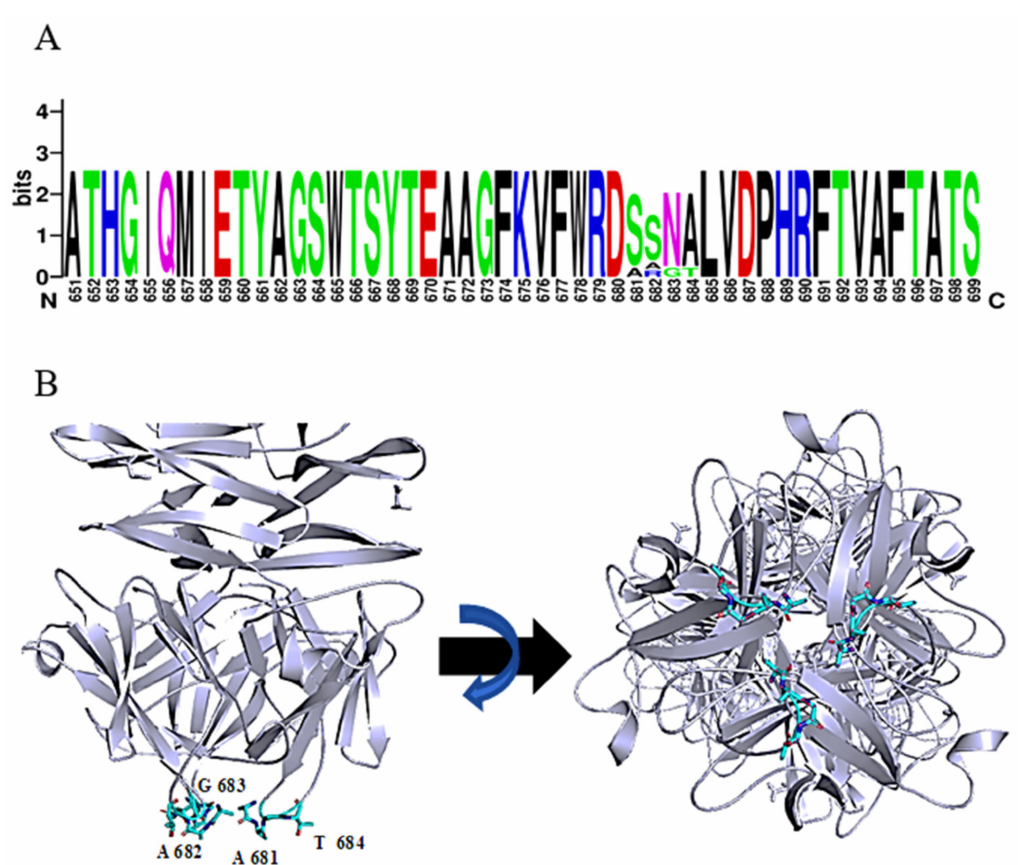
Figure 5. Consensus sequence S/A-S/A/R-N/G-A/T in the most ultimate loops of the C-terminal domain of DpoMK34. ( A ) Sequence identity with a variable region of 4 amino acids, visualized with WebLogo. ( B ) Predicted 3D model of DpoMK34 with the variable 4 amino acids located at C-terminal loop (Cyan colored residues; side and bottom